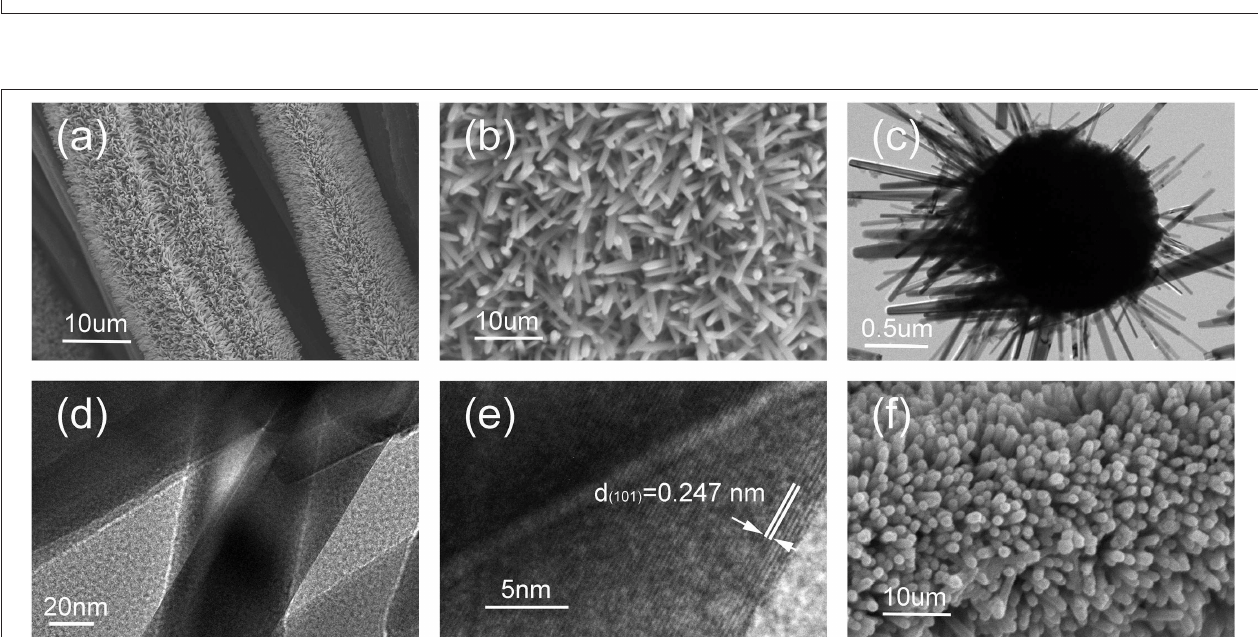
FIGURE 3 | SEM and TEM images of the prepared precursors. (a,b) SEM images of CC/ZnO nanorod arrays at different magnifications. (c) TEM images of CC/ZnO nanorod arrays. (d,e) HRTEM images of CC/ZnO nanorod arrays. (f) SEM images of CC/ZnO/SnO 2 core-shell nanorod arrays.